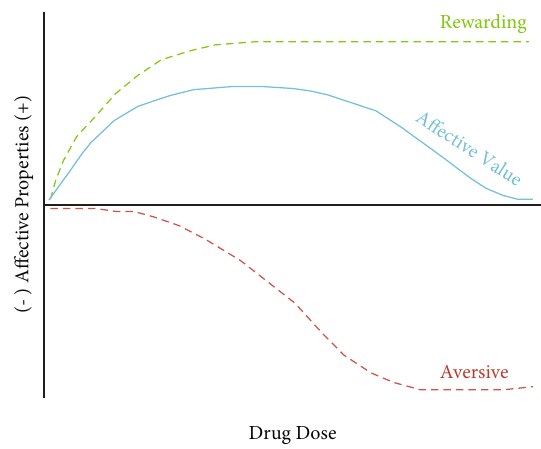
Figure 3: A hypothetical model of the aversive and rewarding e ff ects of a drug and their potential interaction to impact its self- administration (which is a function of the overall a ff ective response to the drug). The drug produces both aversive and rewarding e ff ects in a dose-dependent manner. As illustrated in this speci fi c example, the drug ’ s rewarding e ff ects are produced at lower doses that increase the drug ’ s overall a ff ective property that, in turn, drives the drug ’ s intake. With increases in the dose, the drug ’ s rewarding e ff ects asymptote while the drug ’ s aversive e ff ects increase, reducing the overall a ff ective value of the drug and decreasing the drug ’ s self-administration. In this model, the drug ’ s rewarding e ff ects are assumed to initiate and maintain drug intake (at least under acute conditions) while its aversive e ff ects limit it. The nature of such an interaction is not static and depends upon a host of factors (see Sections 11 and 12). Further, the relative contributions of the aversive e ff ects in limiting intake change as drug intake go from regulated to dysregulated given the change in the reward valence from positive to negative. Created with